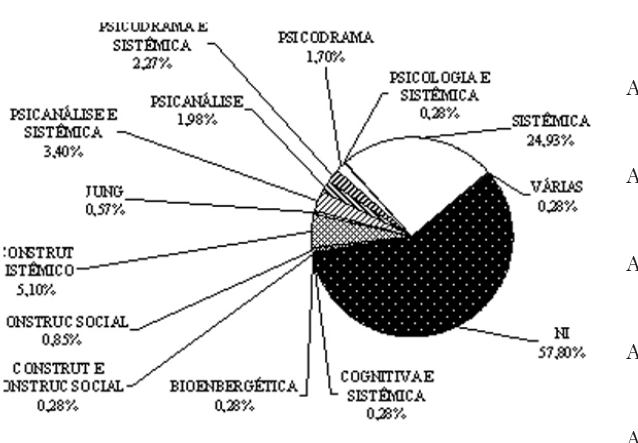
Figura 8. Referências teóricas apresentadas no Caderno de Resumos do V Congresso Brasileiro de Terapia de